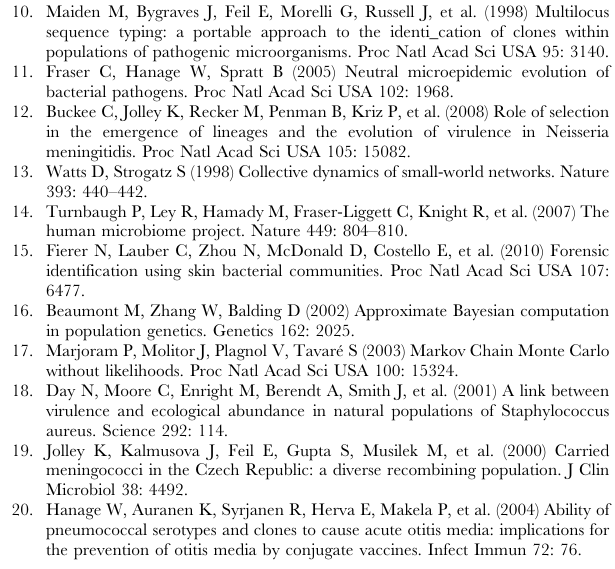
Figure S2 Scatter plot of network distance (degrees of separation) versus allelic difference (number of discordant alleles) for all pairs of nodes in the network. Points are randomly jittered for illustrative purposes. A linear fit to the data (red line) shows a positive correlation between the two distances, and motivates the idea that distances in isolates can be used as a proxy for network distances between individuals. Figure S3 The type I error for all combinations of observed pairwise distances (see Methods).